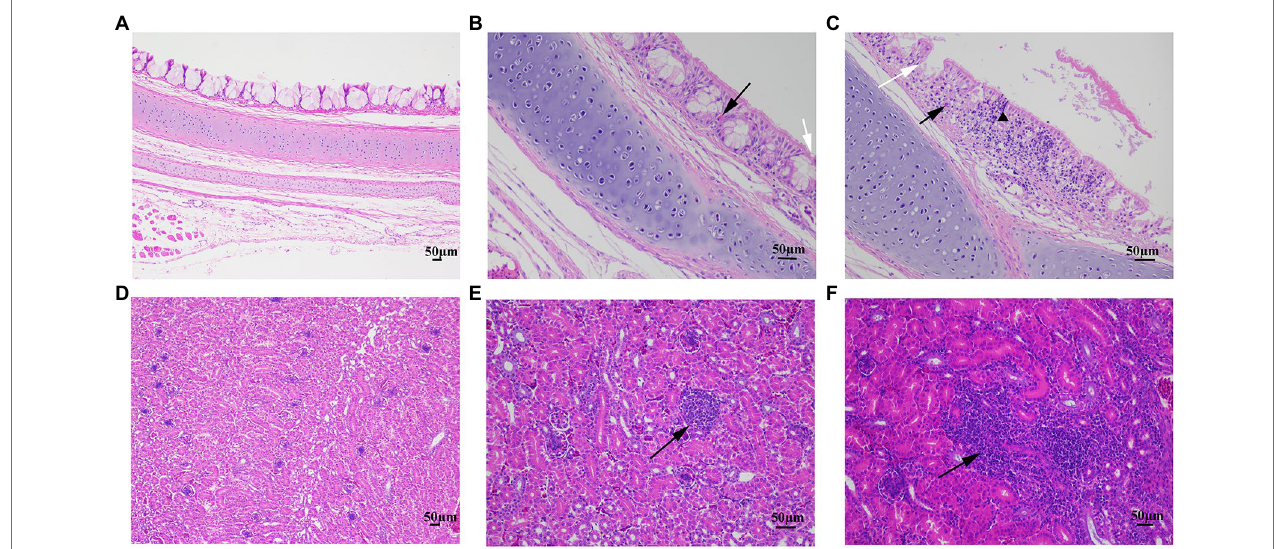
FIGURE 6 | The microscopic lesions in the trachea and kidney of chickens challenged with rescued virus and zy30 strains. (A) Normal trachea. (B) Slight loss of cilia (white arrow) and bleeding (black trigon) in the ciliated epithelial cells. (C) Bleeding (black arrow), infiltration of lymphoid cells (black trigon), and necrosis (white arrow) in the tracheal ciliated epithelial cells following the challenge. (D) Normal kidney. (E) Localized infiltration of lymphoid cells in the kidneys. (F) Abundant infiltration of lymphoid cells in the kidneys (black